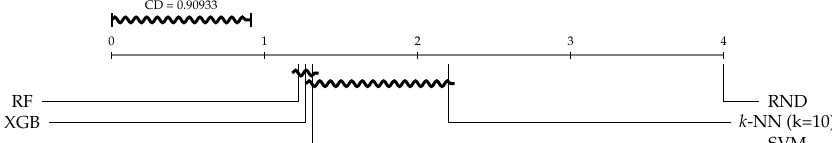
Figure 4. Comparison of all classifiers against each other with the Nemenyi test considering its accuracy results. The connected group of classifiers are not significantly different (at α =